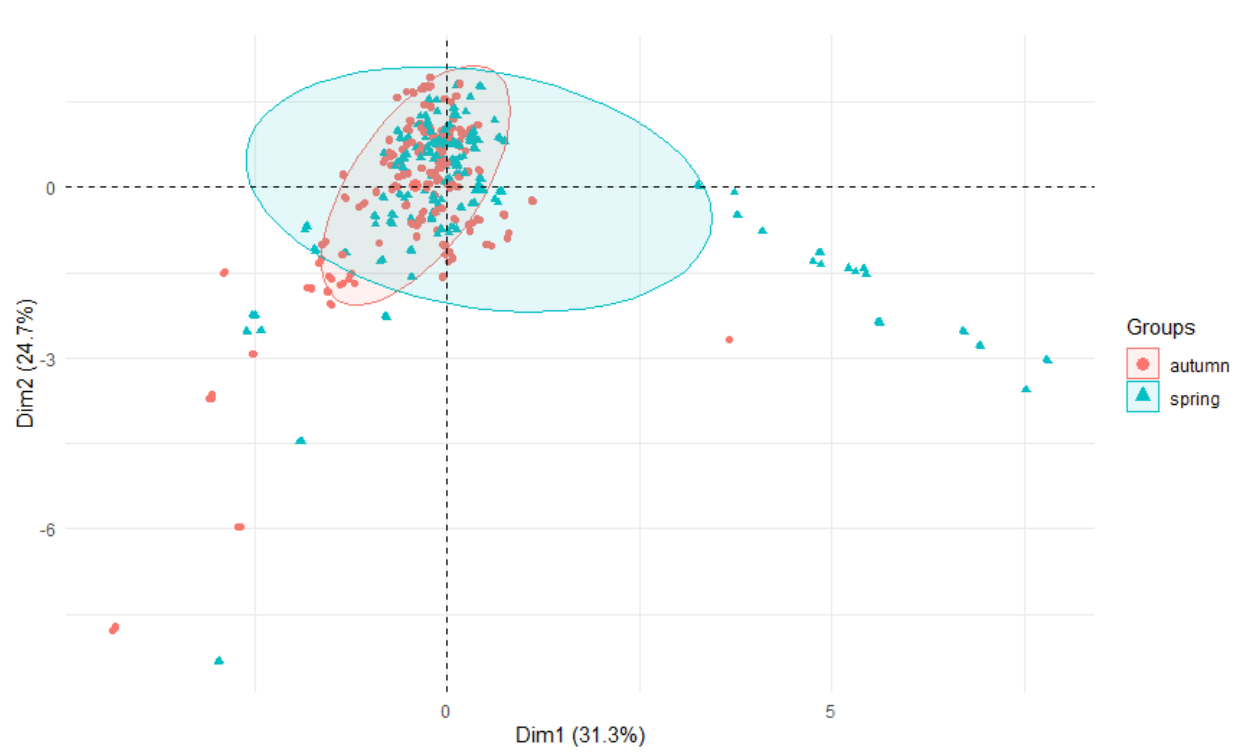
Figure 11. PCA plot 2D showing clustering of metals concentration in plants from rivers across 29 sites and 4 years (2015–2018) grouping factor—season.